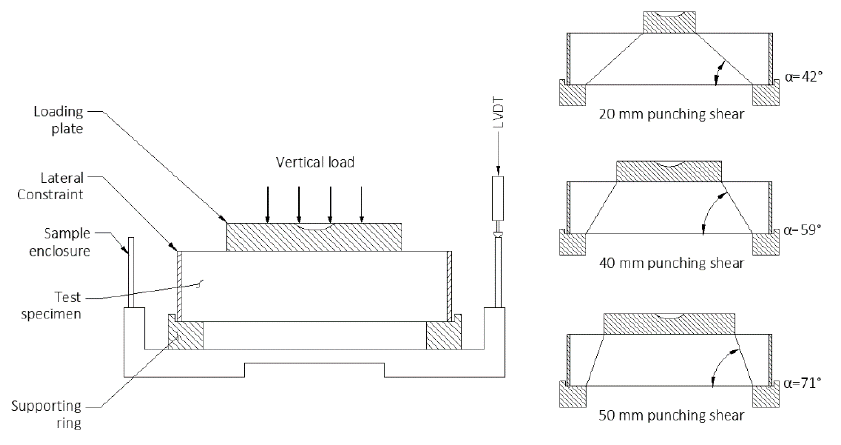
Figure 3. Cross-section diagram of punching shear